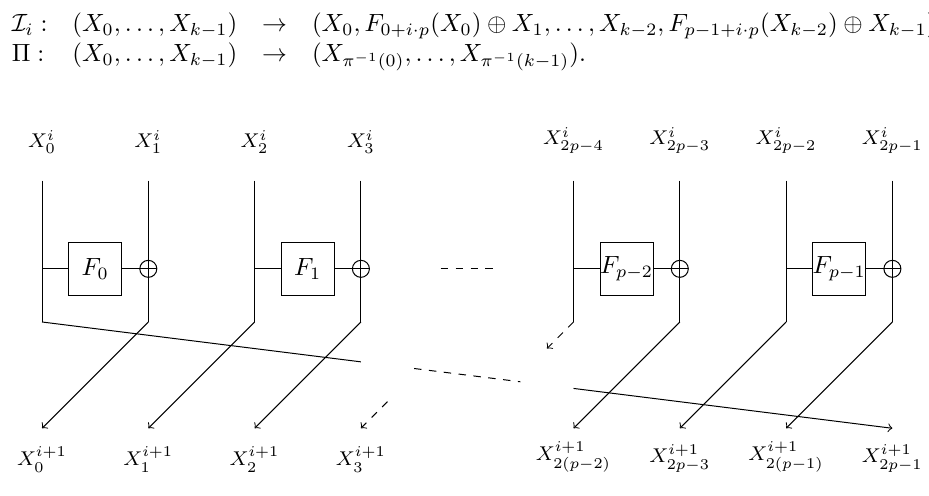
Figure 1: Round function of a Type-II Feistel Scheme